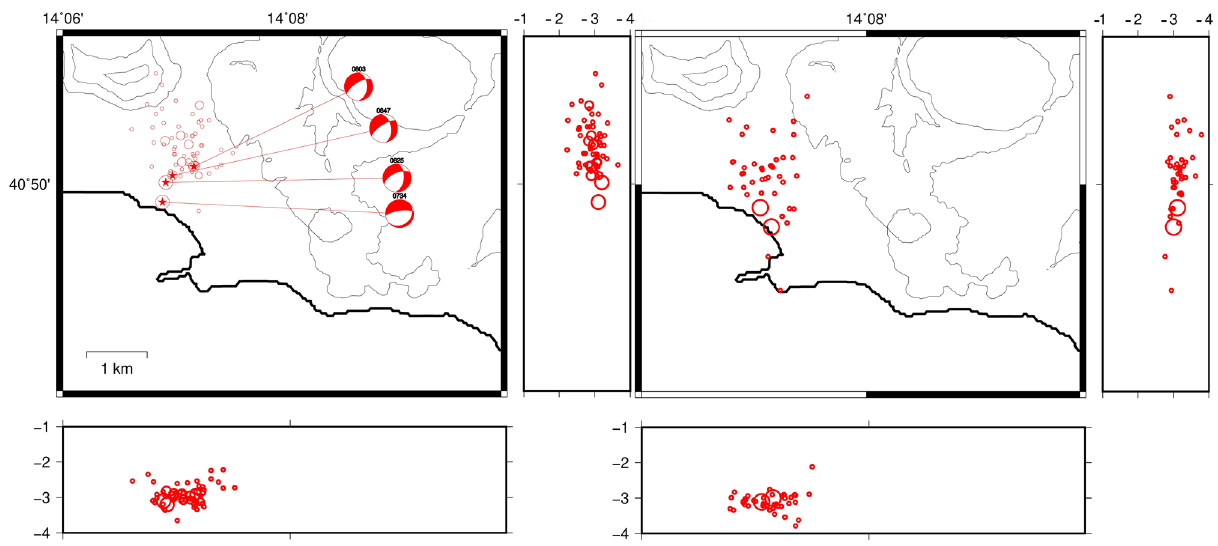
Figure 3. Location of the earthquakes of the swarm of 7/9/2012 using NLLoc (sx) and HypoDD (dx). Circle sizes are proportional to the earthquake magnitude. The beach balls of focal mechanisms are obtained using the program FPFit. The images were obtained using the free software GMT 5.3.1 (https:// www. gener ic- mappi ng- tools.